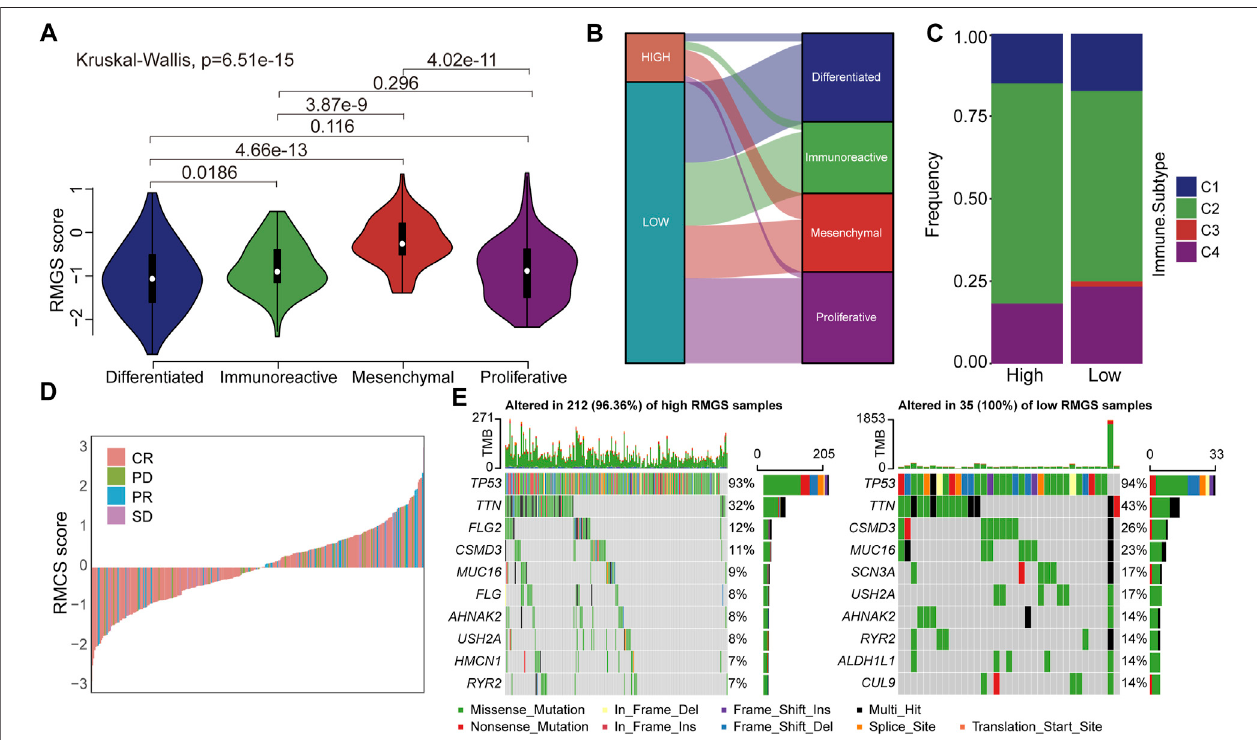
FIGURE 4 | (A) Violin plots illustrated the correlation between the RMGS score and molecular subtypes (B) Alluvial diagram for the RMGS groups versus different intrinsic molecular subtypes (C) Association between the RMGS and the immune subtypes (D) Waterfall plot illustrated the RMGS score with different immunotherapy responses (E) Oncoplot of top 10 mutation genes in high- and low-RMGS